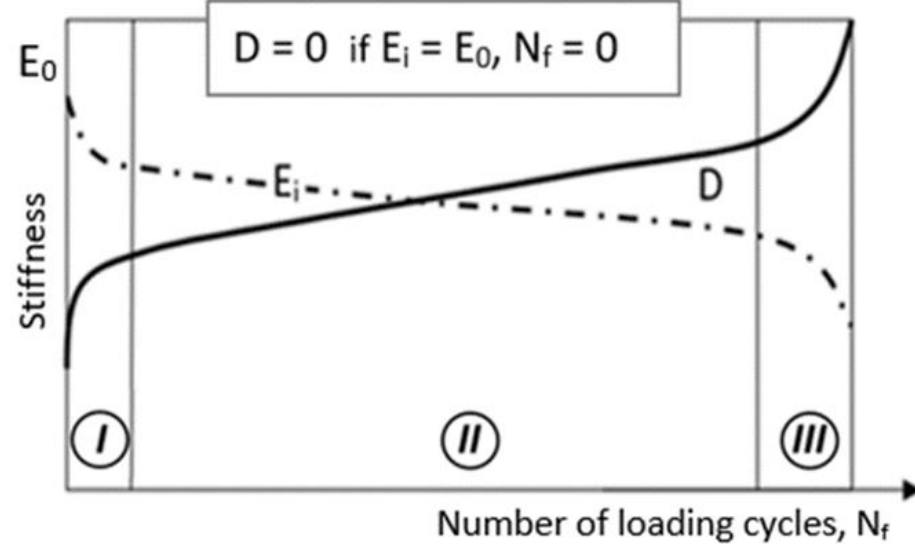
Figure 3. Illustrative diagram of an evolution of damage during uniaxial tensile cyclic loading. Based on damage parameter suggested here and accompanying loss of stiffness, the pre-critical state was determined. As a result the cyclic loading process was interrupted prior to the total failure of specimen at the assumed damage state. It has to be mentioned here, that all the aged specimens acquired the same level of degradation (similar stiffness loss). The aged specimens were subsequently subjected to low impact velocity tests on the drop weight